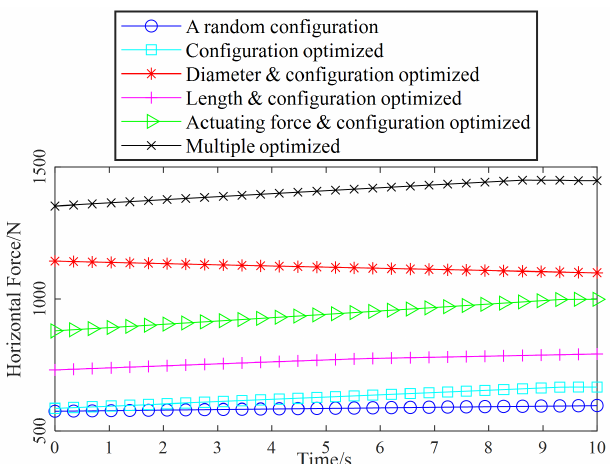
Figure 10. Comparison of the maximum reachable horizontal forces obtained by different optimization solvers along the same given